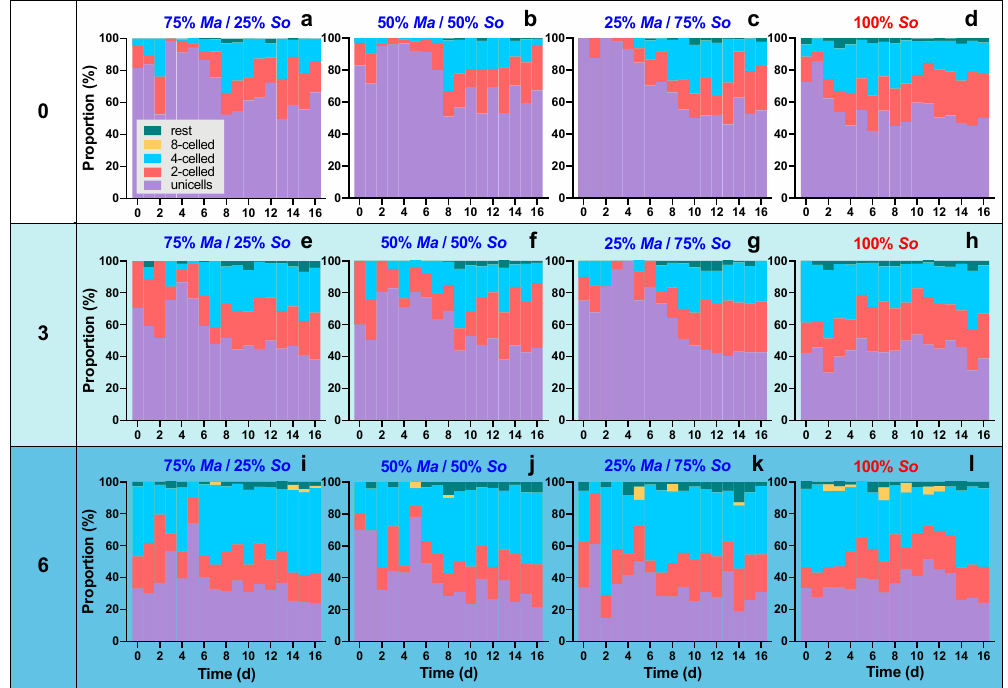
Figure 4. Proportions of unicells and 2-, 4- and 8-celled colonies in S. obliquus populations of monocultures and cocultures with di ff erent initial algal compositions. The “rest” group represents 3-, 5-, 6-, and 7-celled colonies.